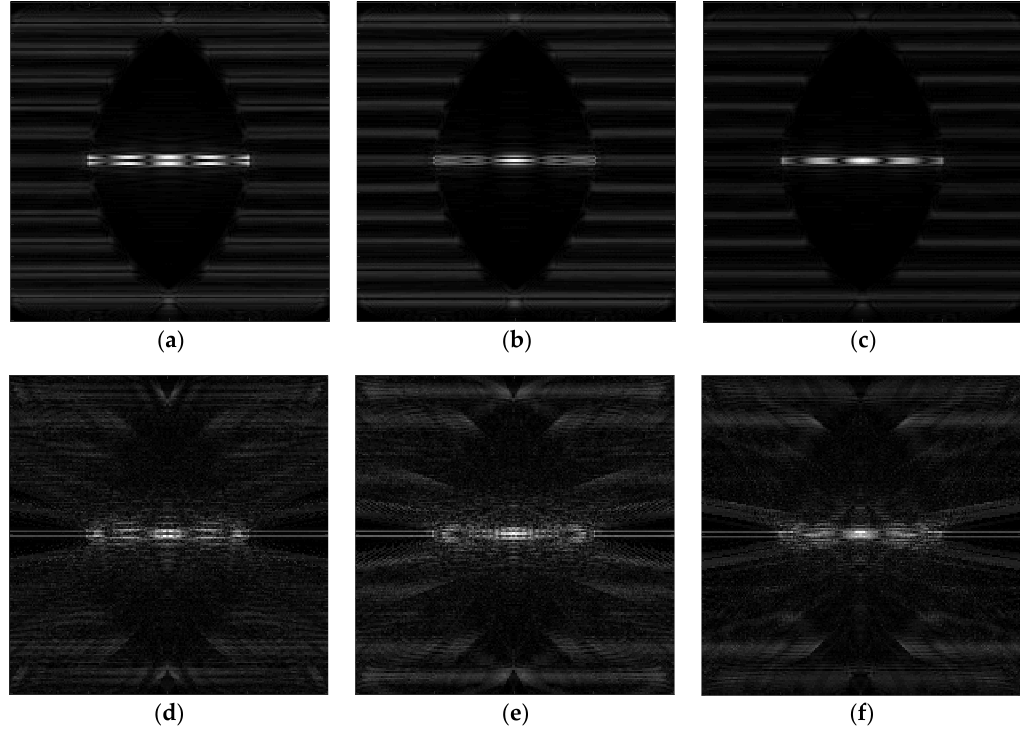
Figure 7. Double-line target imaging with full synthetic aperture. The piecewise linear transformation parameters are T = 0.95, k 1 = 1.2, k 2 = 0.1: ( a , d ) The distance between the two lines is 0.4; ( b , e ) The distance between the two lines is 0.3; ( c , f ) The distance between the two lines is 0.2. The above simulation results show that the imaging result after piecewise linear transformation is better than that of the traditional backprojection algorithm. The imaging results after piecewise linear transformation can distinguish the very close targets which are mixed together in the traditional backprojection algorithm imaging.